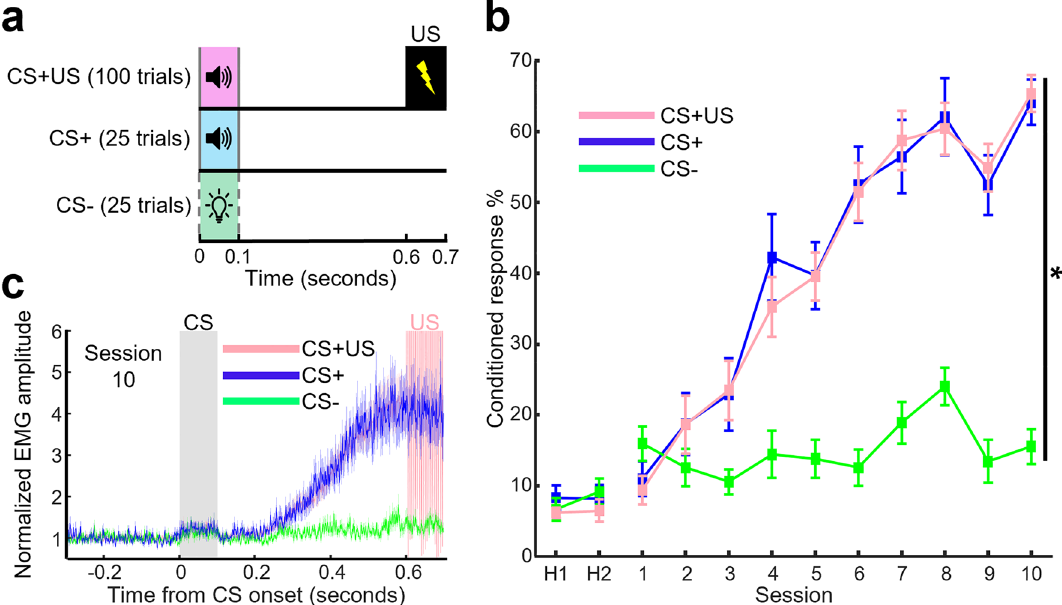
Figure 3. Behavior during photometry recording. ( a ) Behavioral paradigm. The three trial types were randomly intermixed and presented over sessions lasting 75 min. ( b ) Proportion of trials in which rats (N = 13) expressed the CR in each of the three trial types (* p < 0.05, Session × CS Type interaction). Error bars indicate ± SEM. ( c ) Averaged normalized EMG amplitude in session 10. The grey rectangle indicates CS presentation. The high amplitude region of the pink trace (CS+US) represents the artifact caused by the delivery of the US. Shaded areas indicate ±